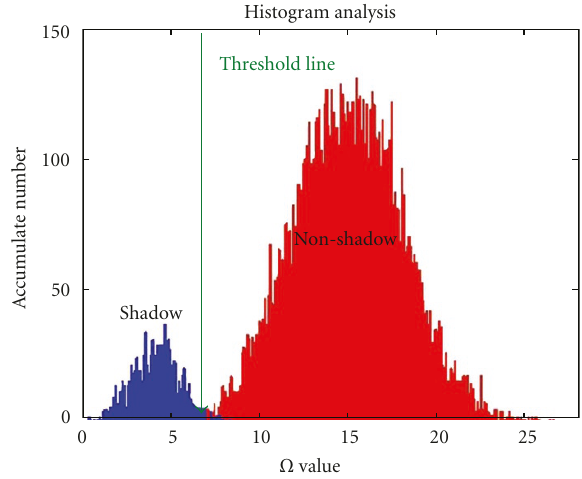
Figure 2: The distribution of POI